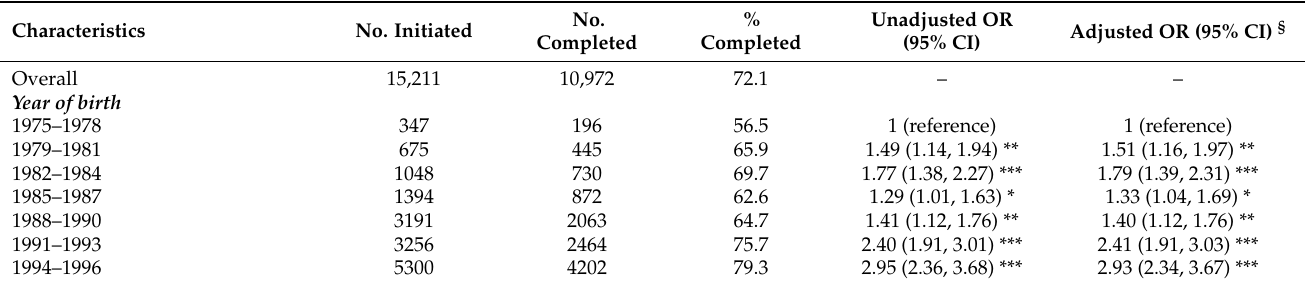
Table 2. Sociodemographic characteristics of HPV vaccination completion among women who initiated opportunistic HPV vaccination in